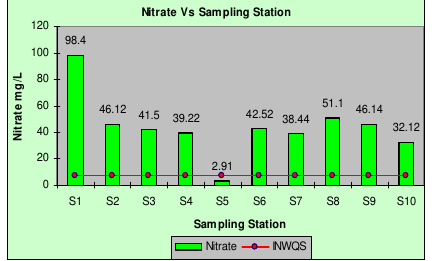
Figure 10 . Phosphorus vs. Sampling Station Metal